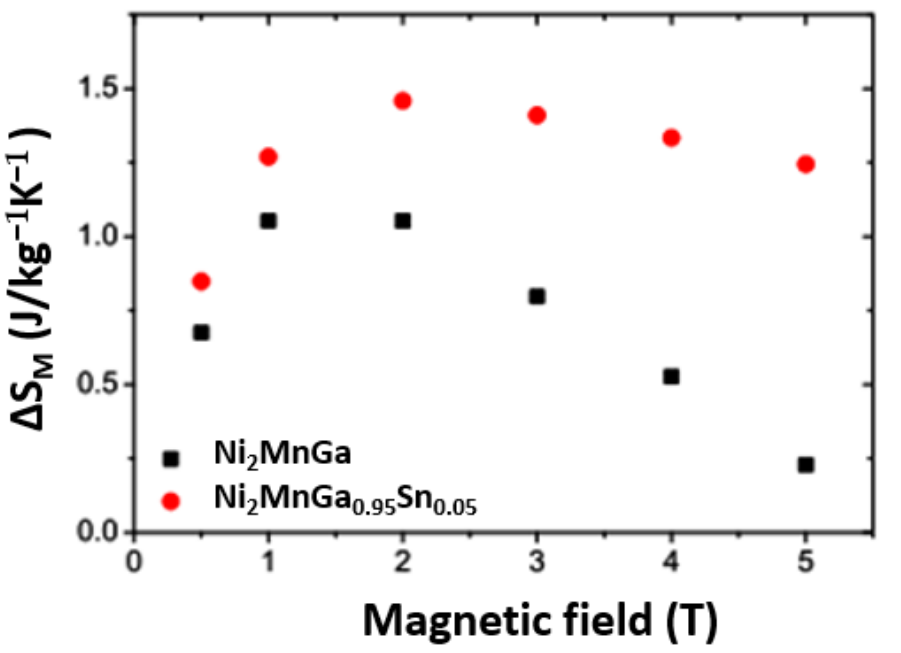
Figure 3. Field dependence of ∆ S M for Ni 2 MnGa 1 − x Sn x ( x = 0 and 0.05) alloys. Reproduced from reference [55]. Copyright 2012 Elsevier.